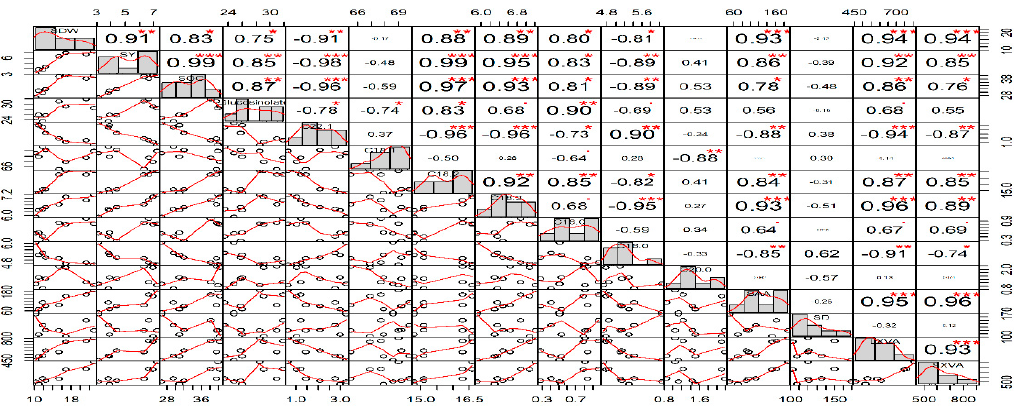
Figure 11. Pearson’s correlation coefficients among growth, yield, fatty acid composition, and anatomical traits of two B. napus cultivars exposed to salinity stress (0 and 100 mM NaCl). Shoot dry weight (SDW); seed yield (SY); seed oil content (SOC); erucic (C22:1); oleic acid (C18:1); linoleic acid (C18:2); linolenic acid (C18:3); stearic (C18:0); palmitic (C16:0); arachidic (C20:0). Stomatal aperture area (SAA); stomata density (SD), leaf xylem vessel area (LXVA); stem xylem vessel area (SXVA). Asterisk “***”,“**”,“*” donate significant at p -values (0.001, 0.01, 0.05).